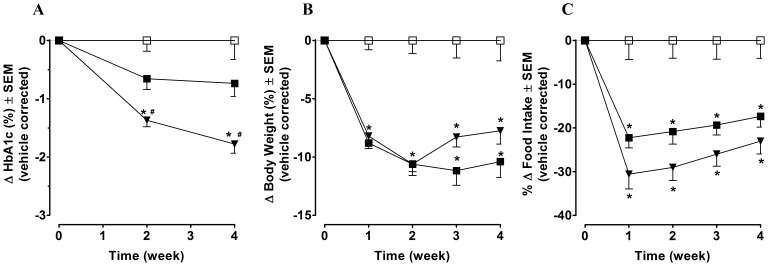
Four-week chronic dosing of peptides in diabetic Lepob/ob Mice.(A) effects on HbA1c (B) effects on body weight and (C) effects on food intake. Vehicle (□), [Leu14]exenatide-ABD (▾) and exenatide (▪). Data are presented as mean ± SEM, n = 10. *p<0.05 vs. vehicle, #p<0.05 vs. exenatide infusion by ANOVA with Tukey’s test.